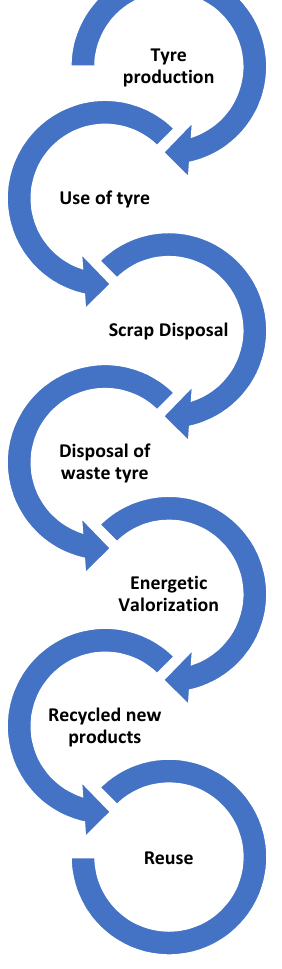
Figure 3. L ife cycle of tyres. Figure 3. Life cycle of